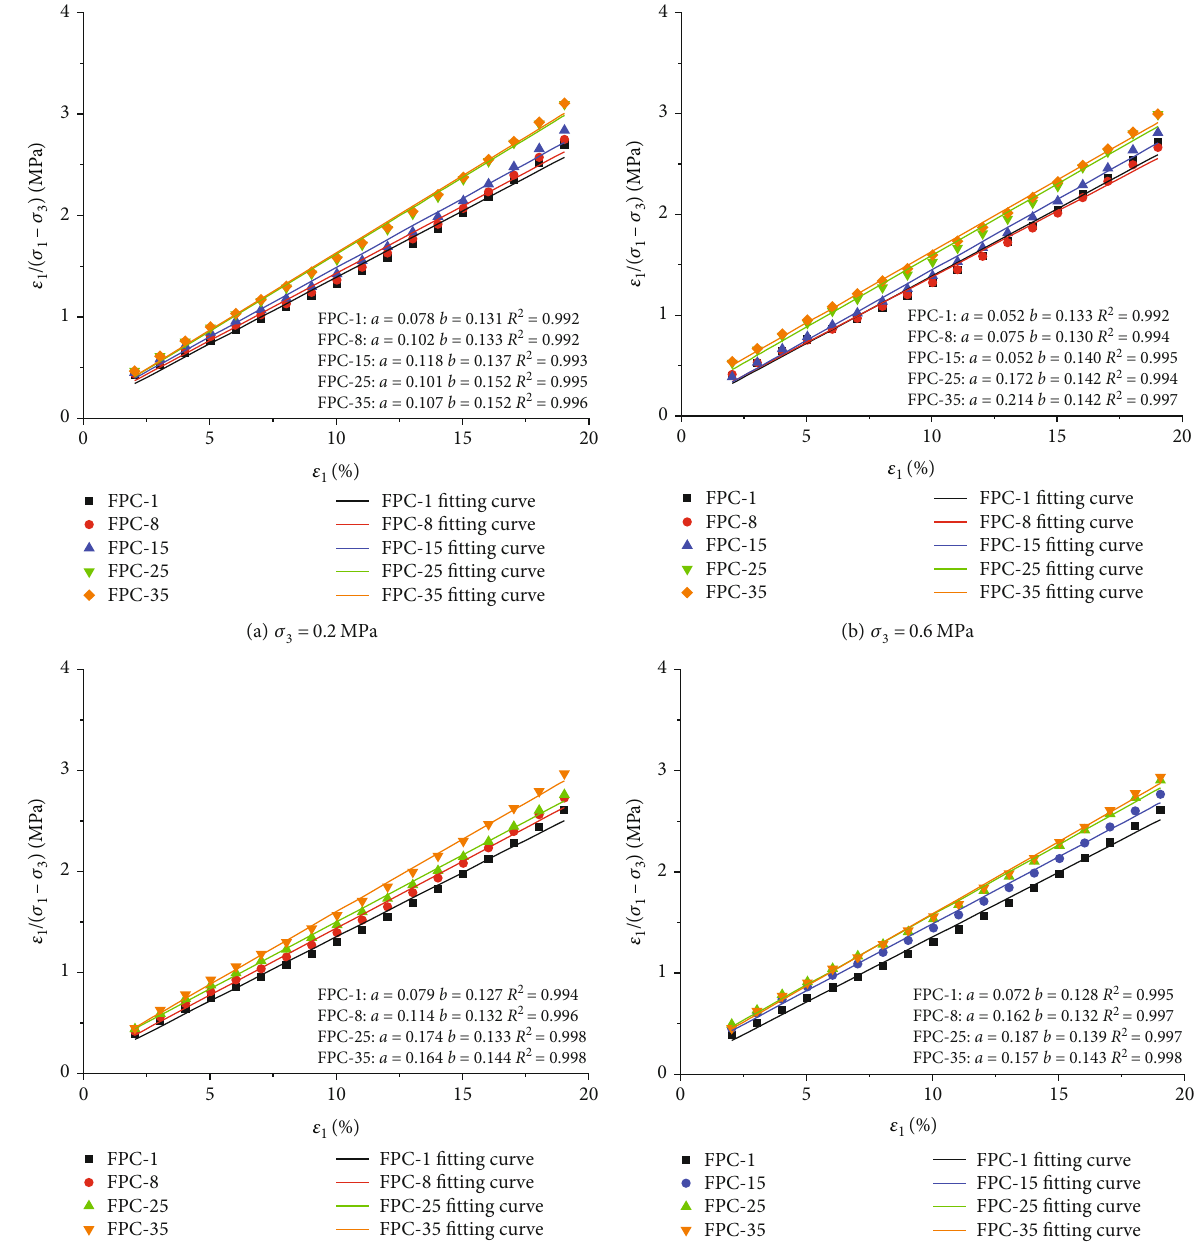
/ ð σ − σ Þ ~ ε 1 1 3 1 of frozen silty sand under di